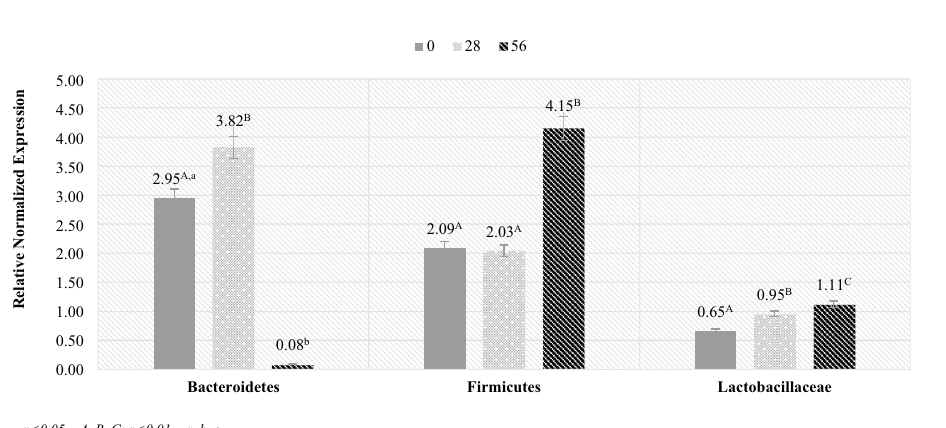
Figure 4. RNE (relative normalized expression) level in the ewes milk. p < 0.05—A, B, C; p < 0.01—a, b,